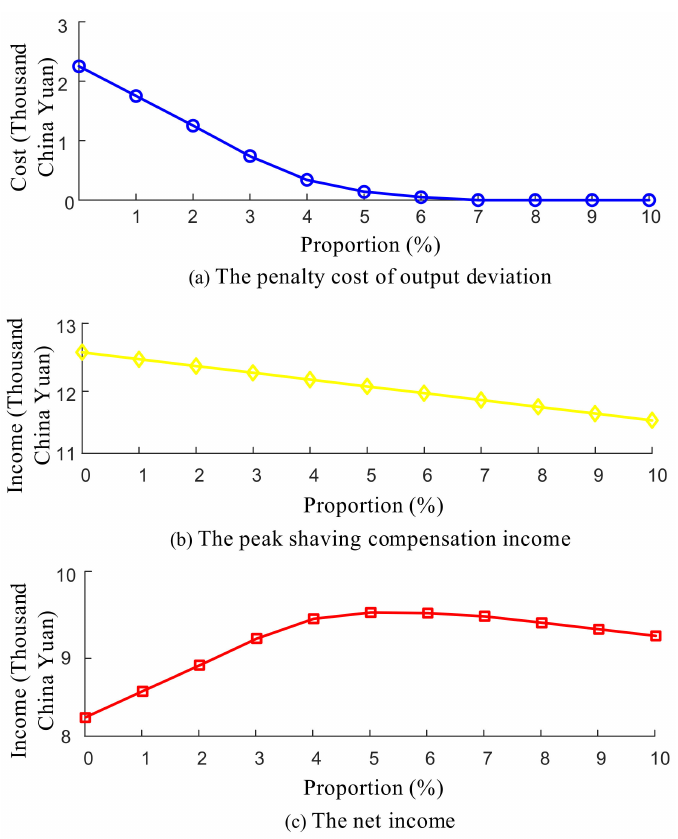
Figure 5. The change curves of income and cost under different proportions of reserve